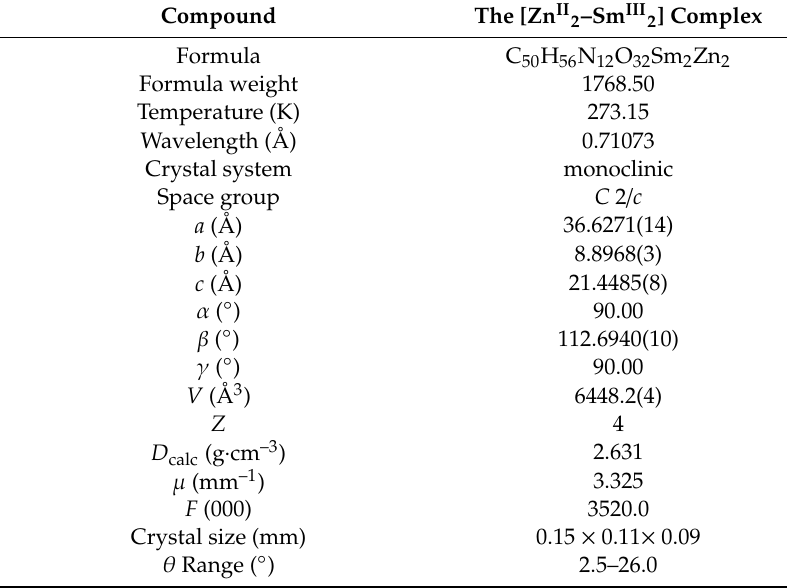
Table 1. CCDC: 1959376. Table 1. Crystal data and refinement parameters for the [Zn II 2 –Sm III 2 ]